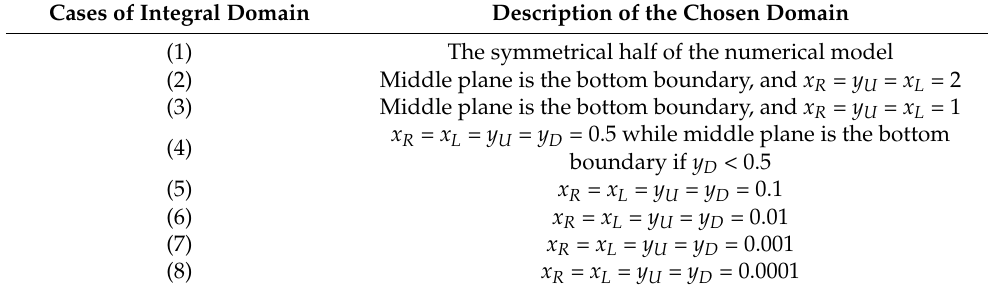
Table 2. Cases of the chosen integral